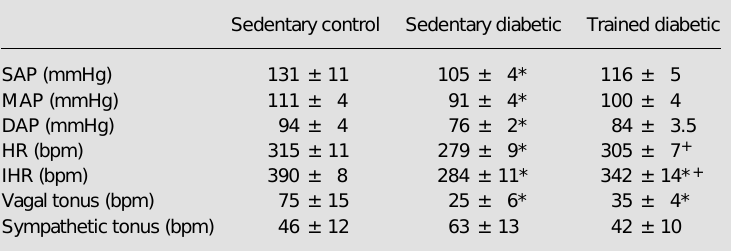
Table 1 - Cardiovascular characterization of sedentary and trained diabetic rats. Data are reported as means ± SEM. *P<0.05 compared to sedentary control rats; + P<0.05 compared to sedentary diabetic rats (Student t -test). SAP = Systolic arterial pressure; MAP = mean arterial pressure; DAP = diastolic arterial pressure; HR = heart rate; IHR = intrinsic heart